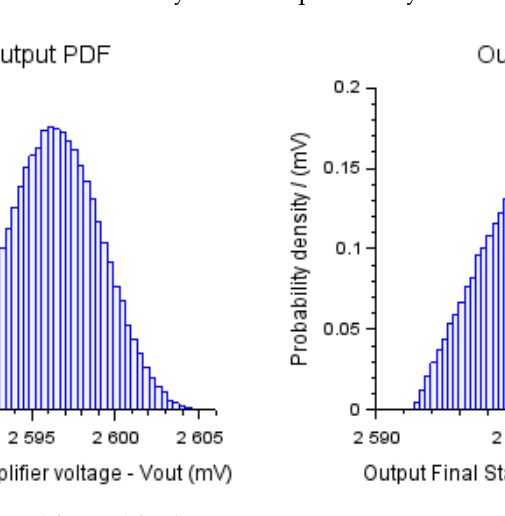
Figure 7. PDF for preamplifier and final stage.